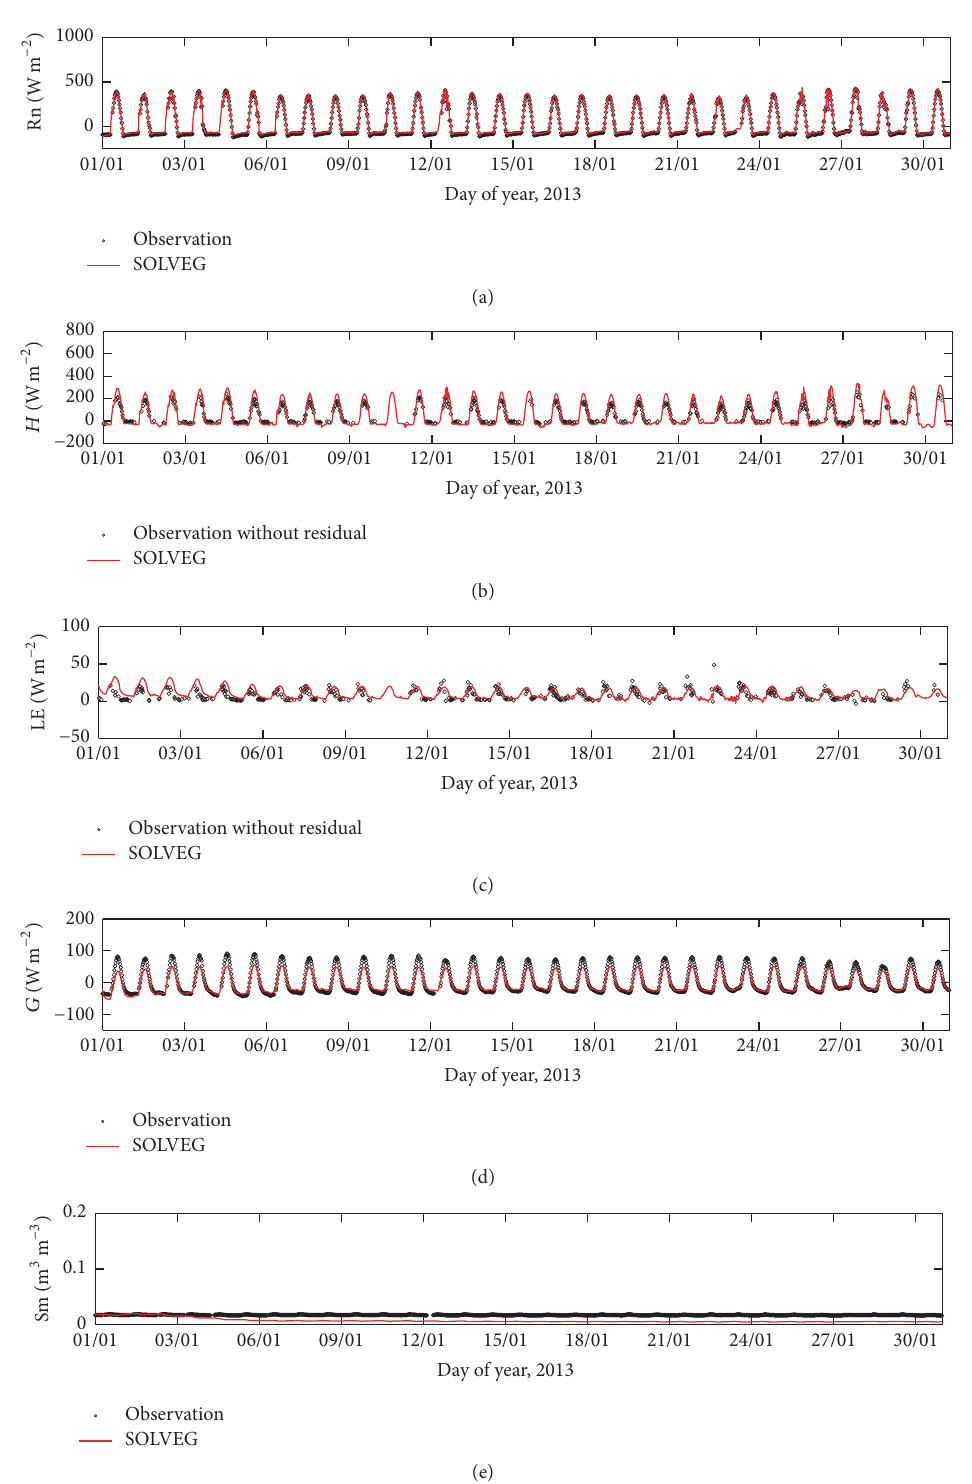
Figure 2: Temporal changes in (a) net radiation, (b) sensible heat flux, (c) latent heat flux, (d) ground heat flux, and (e) volumetric soil moisture content at a depth of 0.03 m at the study site during the dry